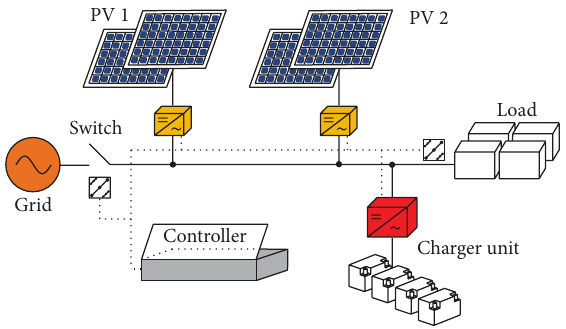
Figure 1: The structure of MG under